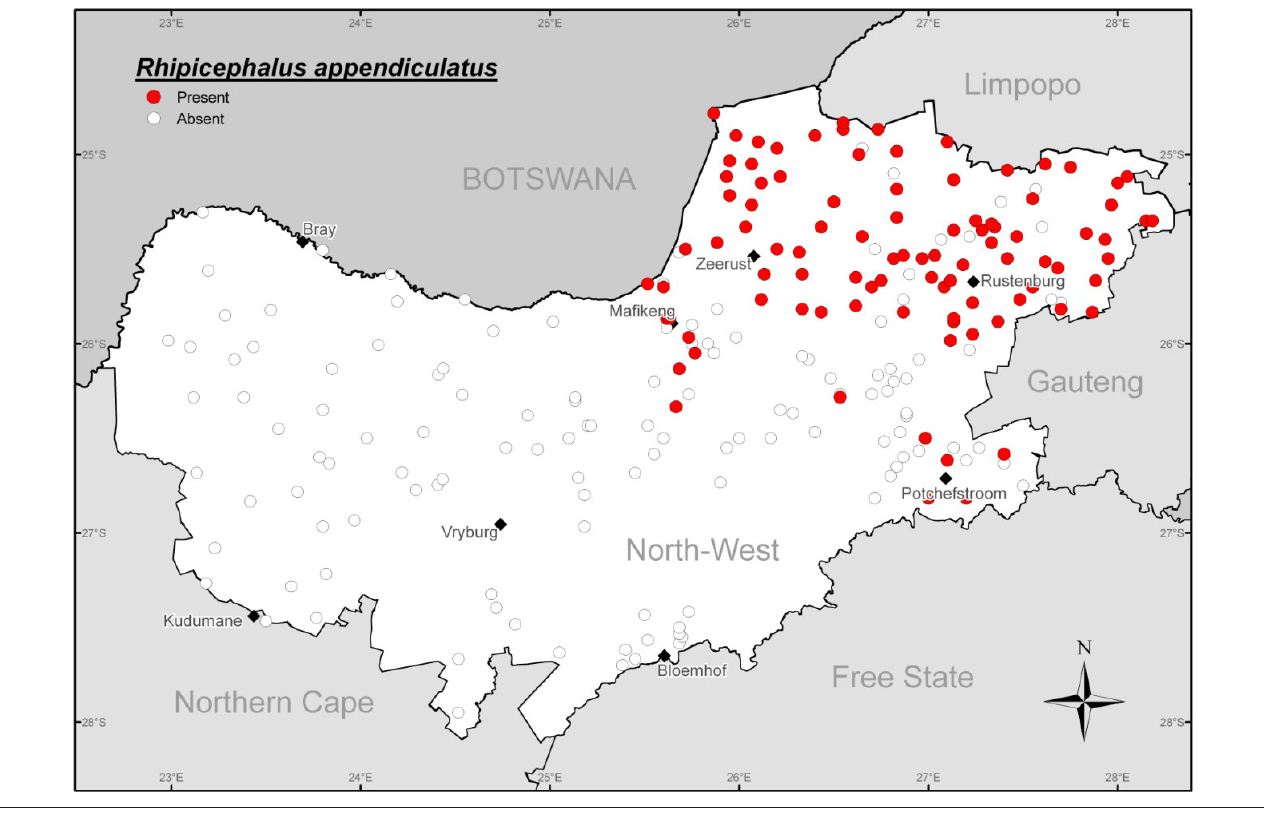
FIGURE 6: The geographic distribution of Rhipicephalus appendiculatus in the North West province, South